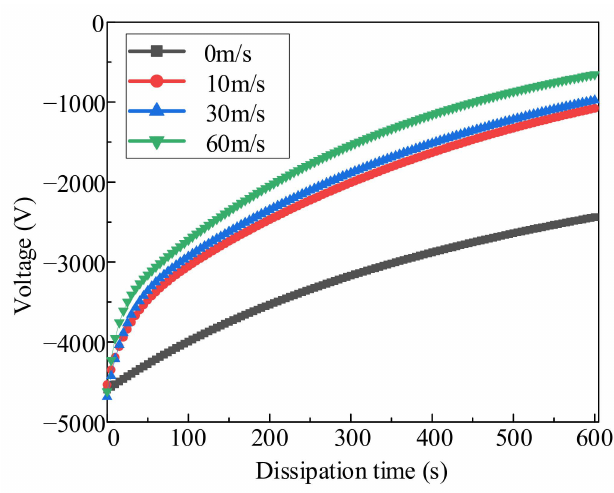
Figure 20. Time dissipation curves for negative polarity